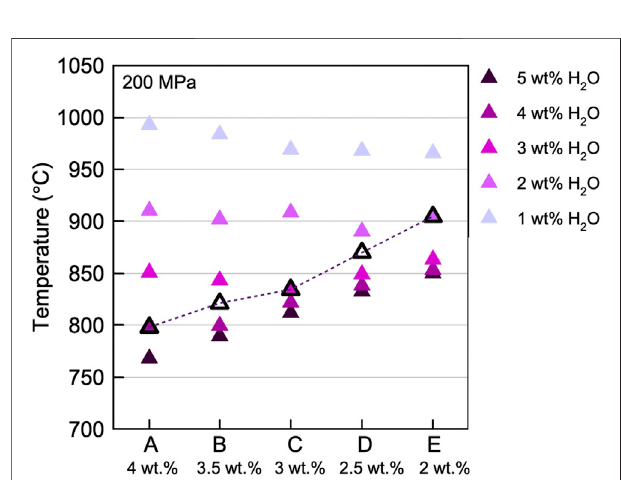
FIGURE 11 | Wet liquidus temperatures calculated from average Rattlesnake Tuff high-silica rhyolite Group compositions at 200 MPa (as seen in Figure 8 ), that now highlights wet liquidus temperatures if water content decreased from 4-2wt% H 2 O from Group A to Group E (black triangles), using the same water contents estimated when calculating melt densities ( Figure 10